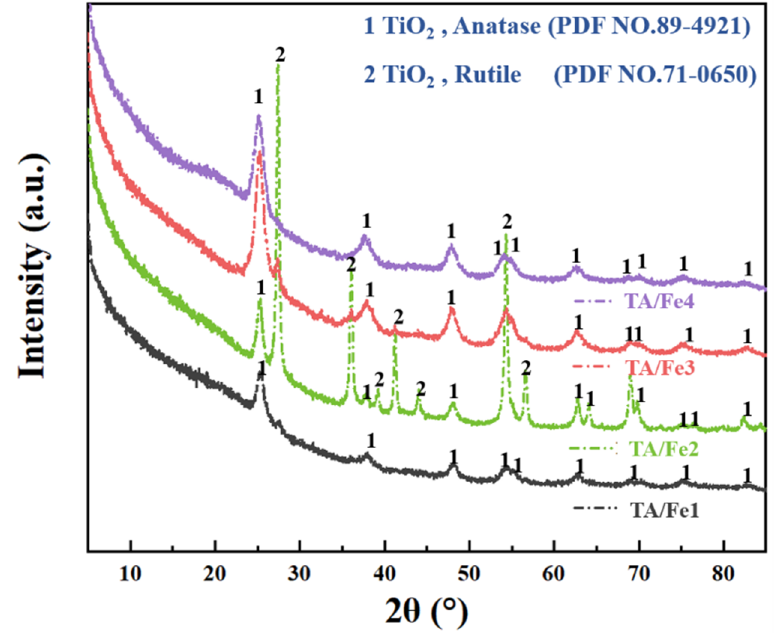
Figure 3. XRD patterns of the TA/Fe1, TA/Fe2, TA/Fe3, and TA/Fe4. N 2 adsorption was used to evaluate the pore structure of the as-prepared aerogel catalysts (Figure 4). As Figure 4a shows, all samples exhibited type IV isotherms with H3 hysteresis loops according to the IUPAC classification, which suggested the existence of narrow meso- pores and macropores in the materials. The adsorption within the low relative pressure region (below P/P 0 = 0.05) was due to the micropores. After thermal treatment at 900 ◦ C, the organic constituent (i.e., resorcinol-formaldehyde) was decomposed into carbon, which generated the micropores. The medium relative pressure region (P/P 0 = 0.05~0.80) implied the magnitude of the specific surface area. The TA/Fe1 had the highest specific surface area of 774 m 2 · g − 1 . There was no platform in the isotherms close to P/P 0 = 1.0, indicating that all samples had macropores. The pore volume and median pore size of the TA/Fe3 are 1.72 cm 3 · g − 1 and 51.6 nm, respectively. The specific surface area of the TA/Fe3 is 543 m 2 · g − 1 . The TA/Fe2 are mainly microporous and mesoporous. Under this doping condition, the specific surface area and pore volume of the TA/Fe2 are 475 m 2 · g − 1 and 0.96 cm 3 · g − 1 , respectively. At this time,